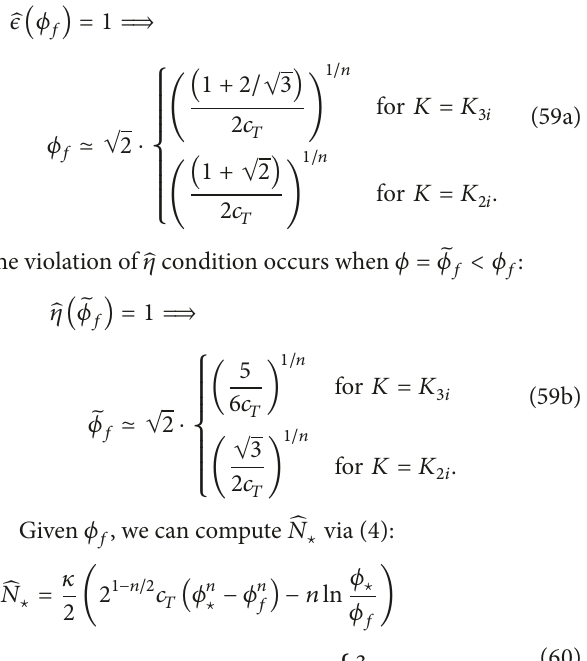
𝐾 = 𝐾 𝐾 = 𝐾 𝐾 = 𝐾 32 or 38 and (b) 23 or 2,11 . The values